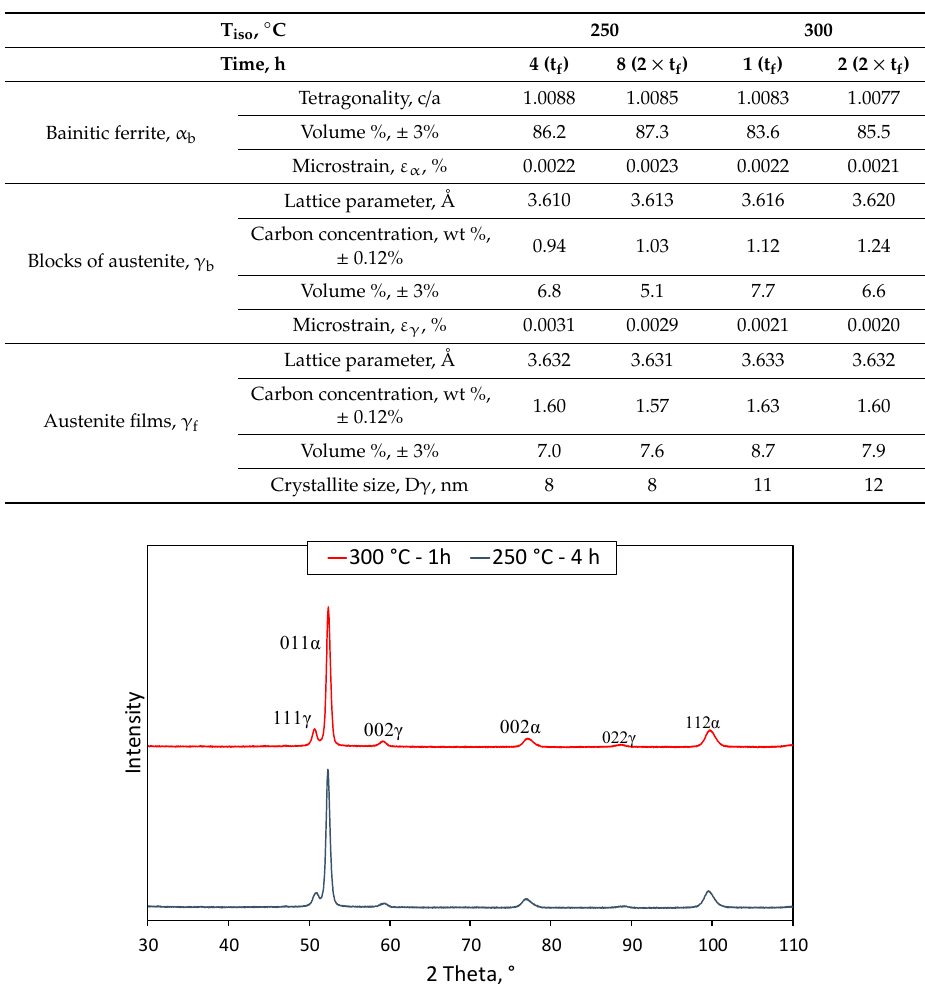
Figure 5. XRD peak profile for microstructures obtained after isothermal transformation at 300 ◦ C-1 h and 250 ◦ C-4 h.